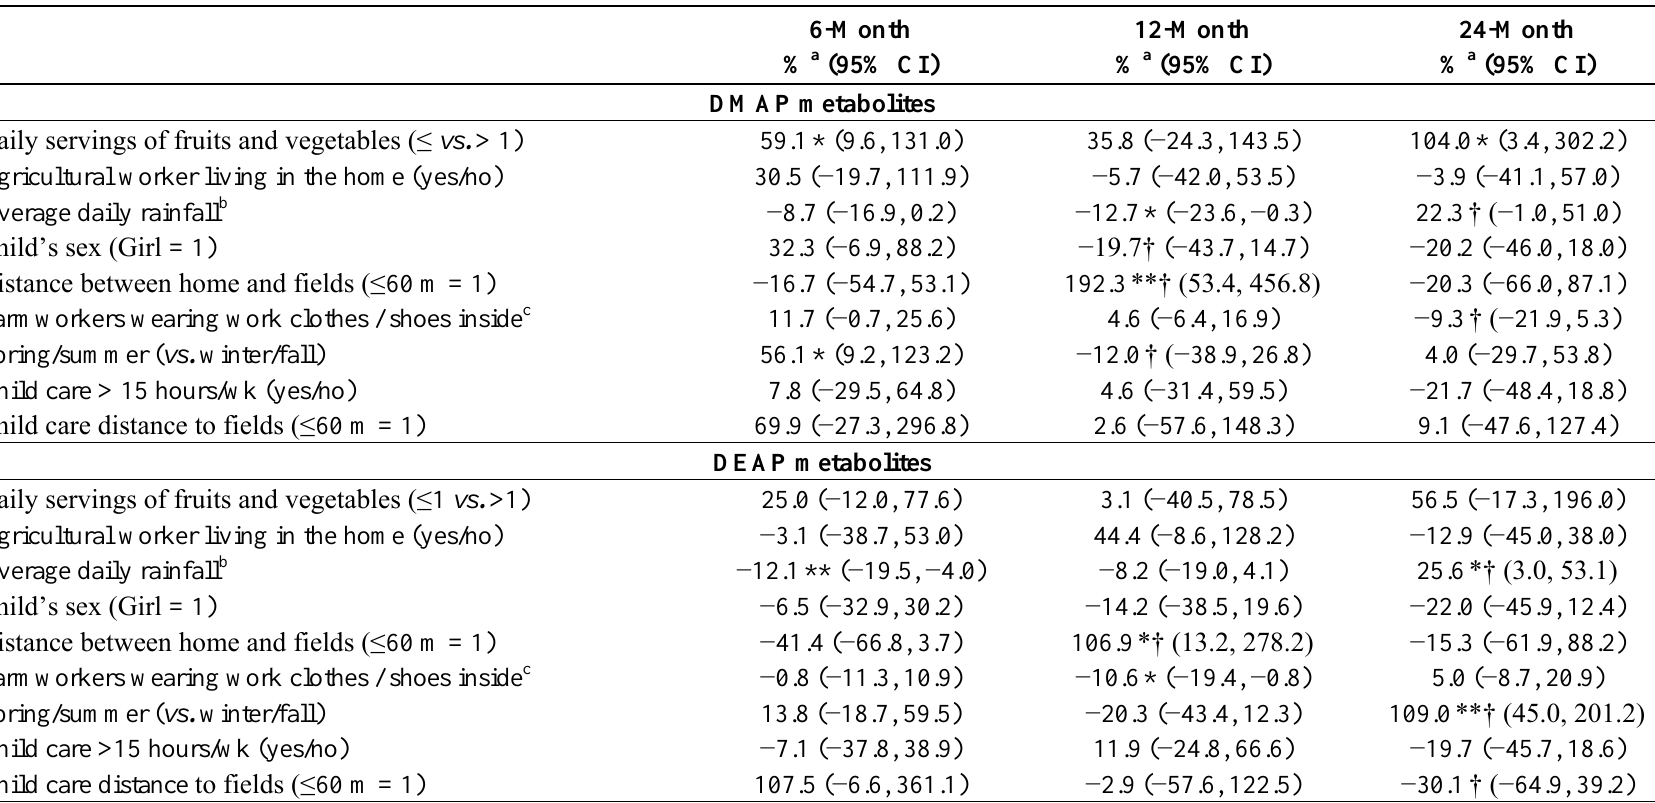
Table 3. Results from generalized linear mixed models of exposure predictors and DMAP and DEAP metabolites (log10) in children 6, 12- and 24-months old (416 children, 1201 urine